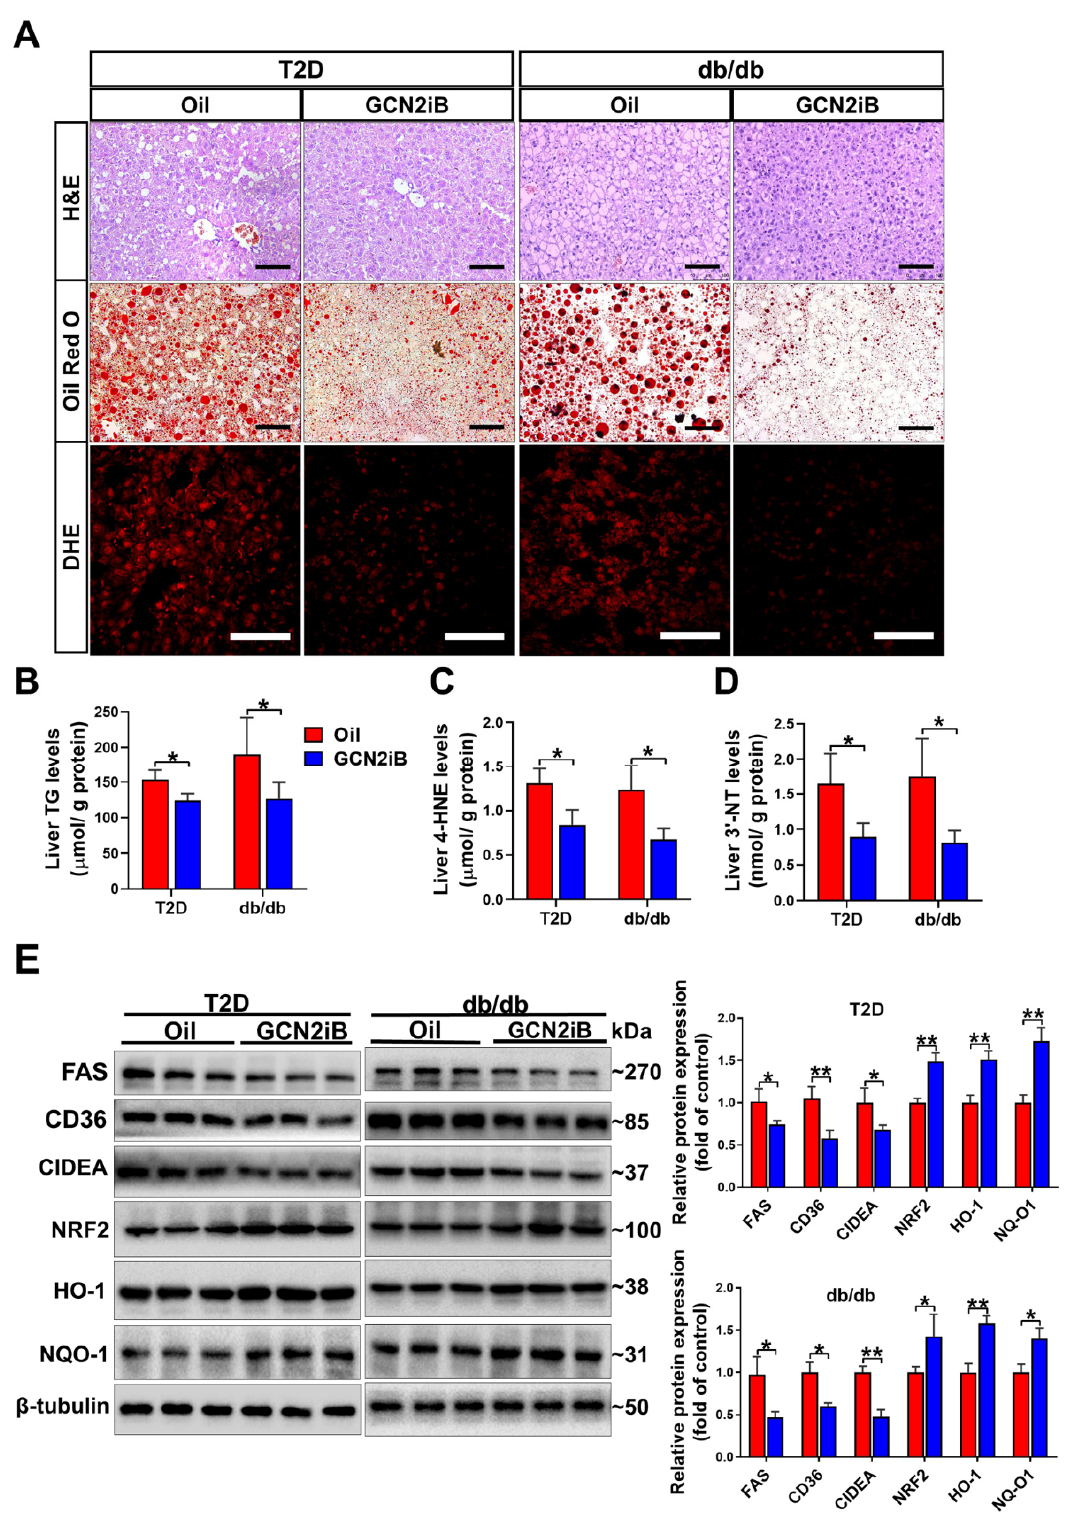
Figure 4. GCN2iB ameliorates hepatic steatosis and oxidative stress in T2D mice. ( A ) Representative liver sections were stained with H&E, oil red O, and DHE. Scale bar = 100 µ m. Liver TG ( B ), 4-HNE ( C ), and 3 ′ -NT ( D ) levels were measured. ( E ) Western blot analyses were performed on the liver lysates from oil and GCN2iB-treated mice. N = 5 ( B – D ) or 3 ( E ); values are means ± SD; * indicates p < 0.05; ** indicates p < 0.01.